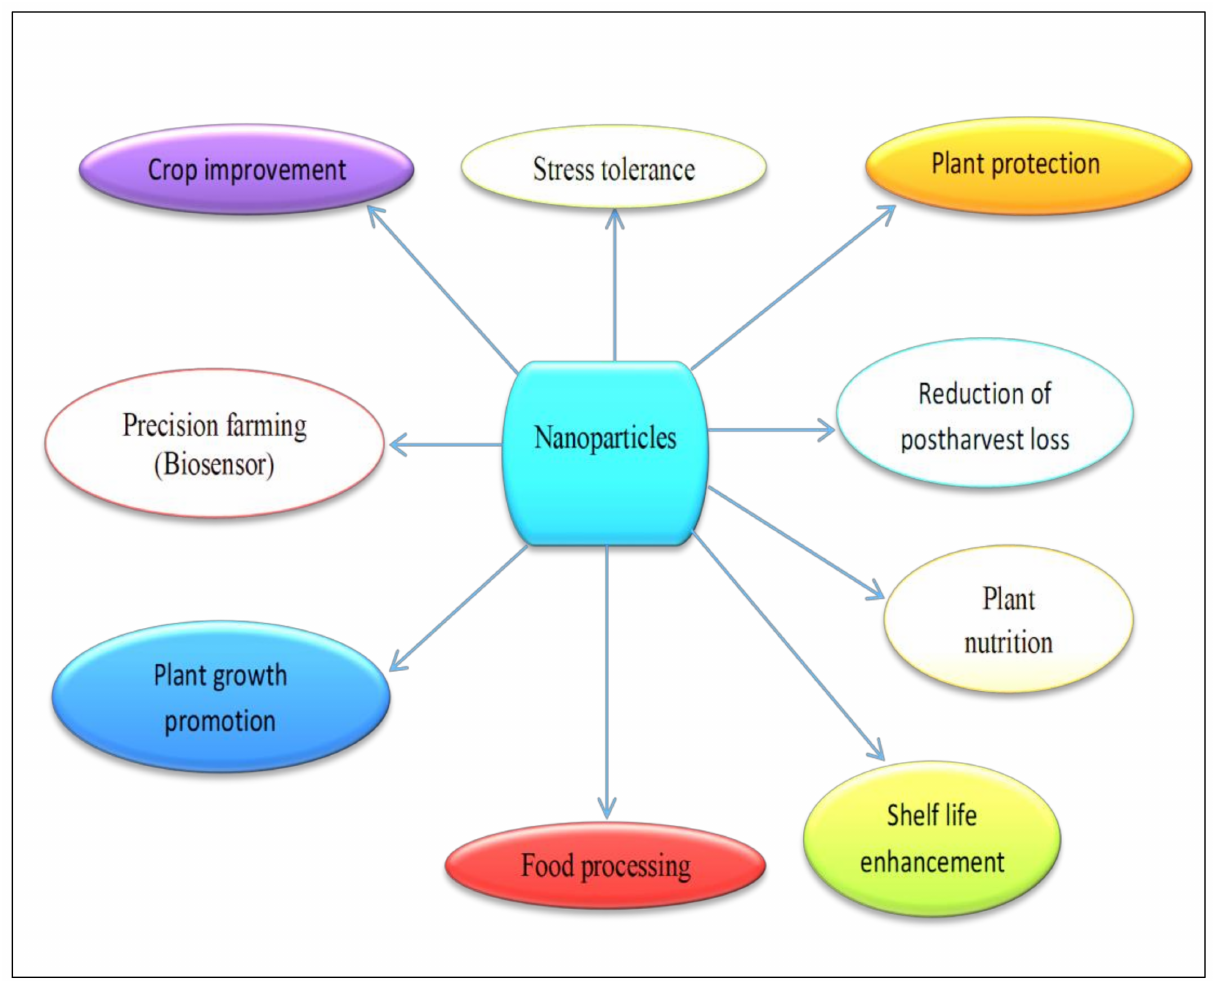
Figure 1. Scope of nanoparticles in agriculture as well as in productivity and quality of horticultural